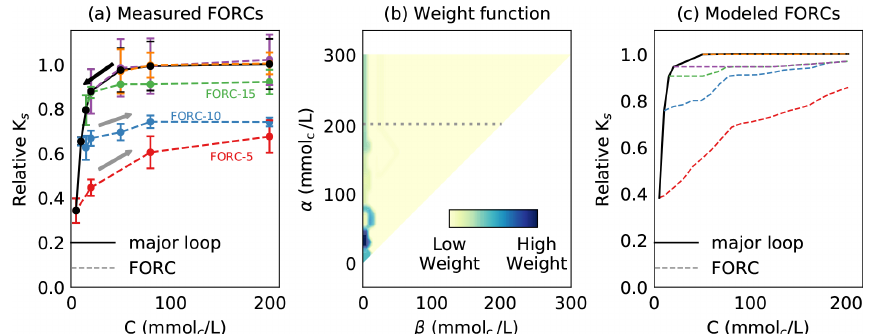
Figure 4. (a) Measured hysteresis in K s , while keeping SAR equal to 20(mmol c L − 1 ) − 1 / 2 constant. The major loop of degradation is shown by the solid black line, while FORCs are denoted by dashed lines. (b) The calculated weight function for the experimental data. Most of the weight is concentrated on the left side of the triangle as a light vertical strip and a heavy stain. (c) Modeled hysteresis graph using the weight function shown in panel (b) . The accuracy of modeled results improves with the number of experimental points.